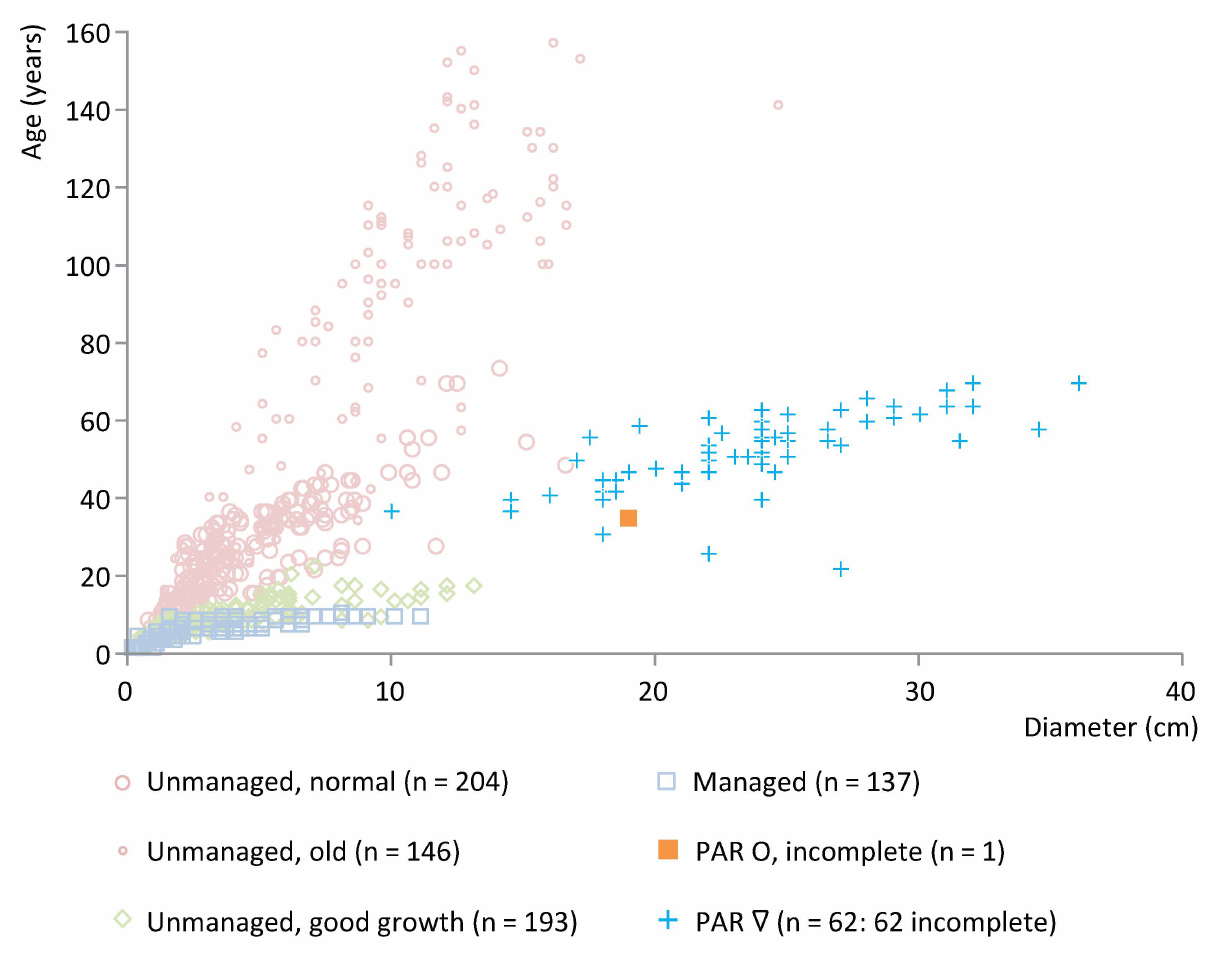
Figure 8. Posts of oak from Parte, cluster IG, plotted against a representative selection of modern oak reference data. O = roundwood, ∇ = split